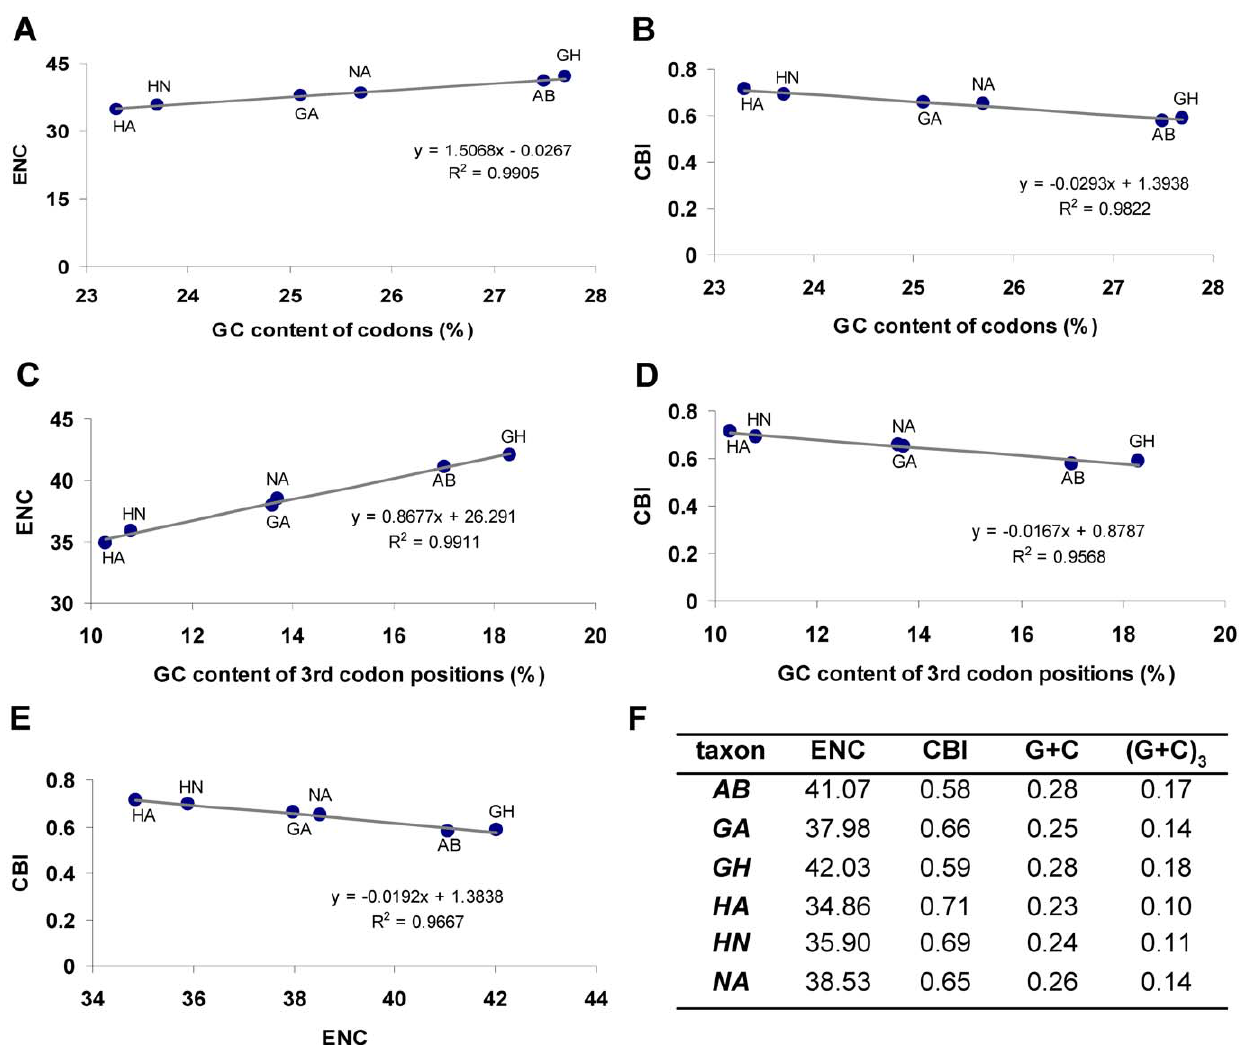
Figure 2. Evaluation of codon bias across six nabid mtDNAs. ENC, effective number of codons (out of a maximum of 61) [21]; CBI, codon bias index [22]; G + C, GC content of codons; (G + C) 3 , GC content of 3rd codon positions.